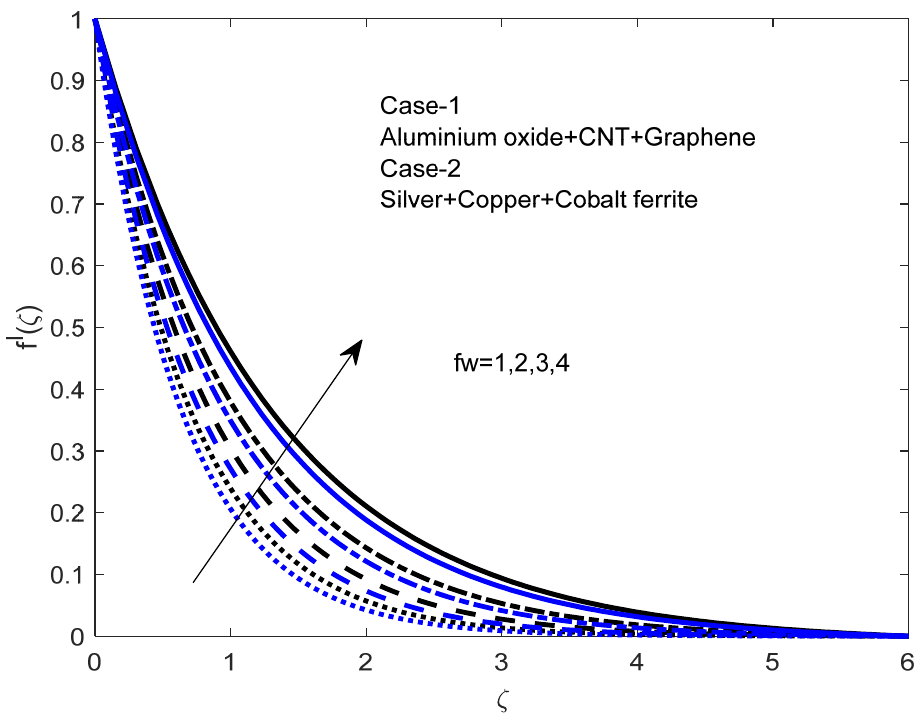
Figure 1. The effect of w f on the velocity profile.